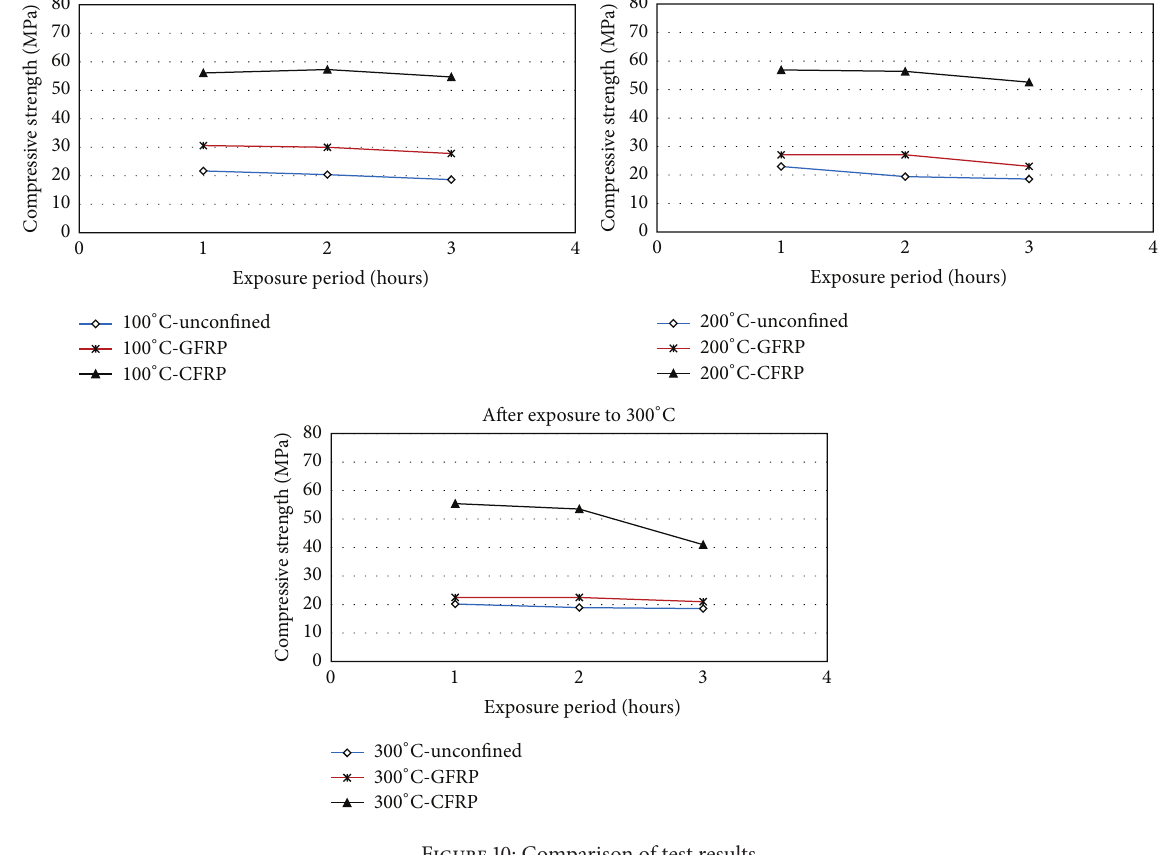
Figure 10: Comparison of test